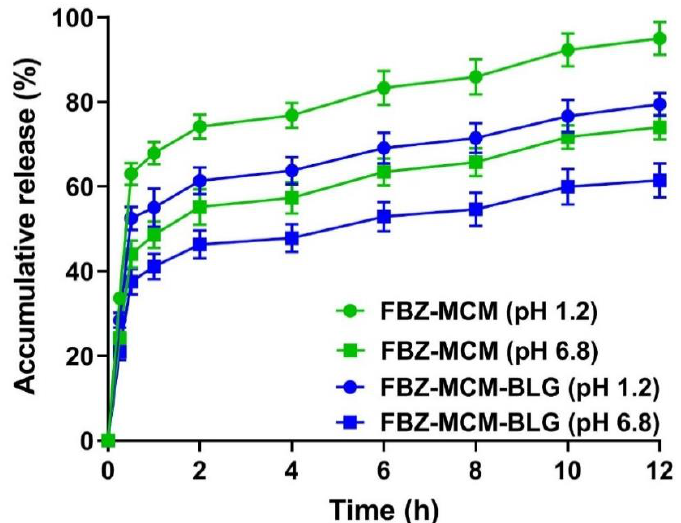
Figure 5. Drug release pattern from FBZ-MCM and FBZ-MCM-BLG nanoparticles, calculated at pH 1.2 and 6.8. One-way analysis of variance (ANOVA) and F tests were used for statistical analysis of the data. Additionally, the values of the slope (accumulative release/hour) for FBZ-MCM and FBZ-MCM-BLG at pH 1.2 were 5.0 and 4.2, respectively, whereas these values at pH 6.8 were 4.2 and 3.4, respectively. The data are expressed as mean ± SD ( n = 3).